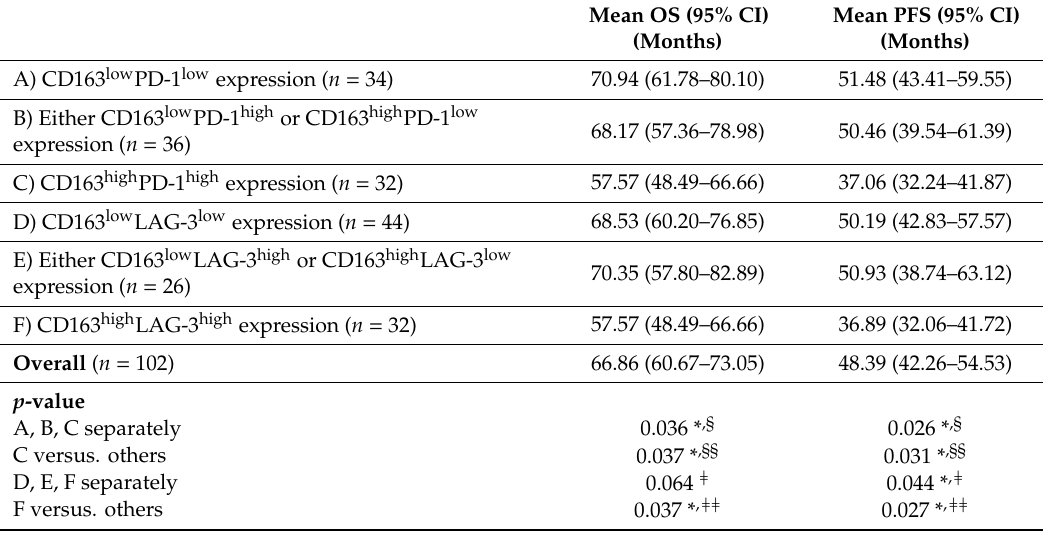
Table 3. Survival outcomes of 102 patients with cutaneous melanoma according to CD163, PD-1, and LAG-3 expression.